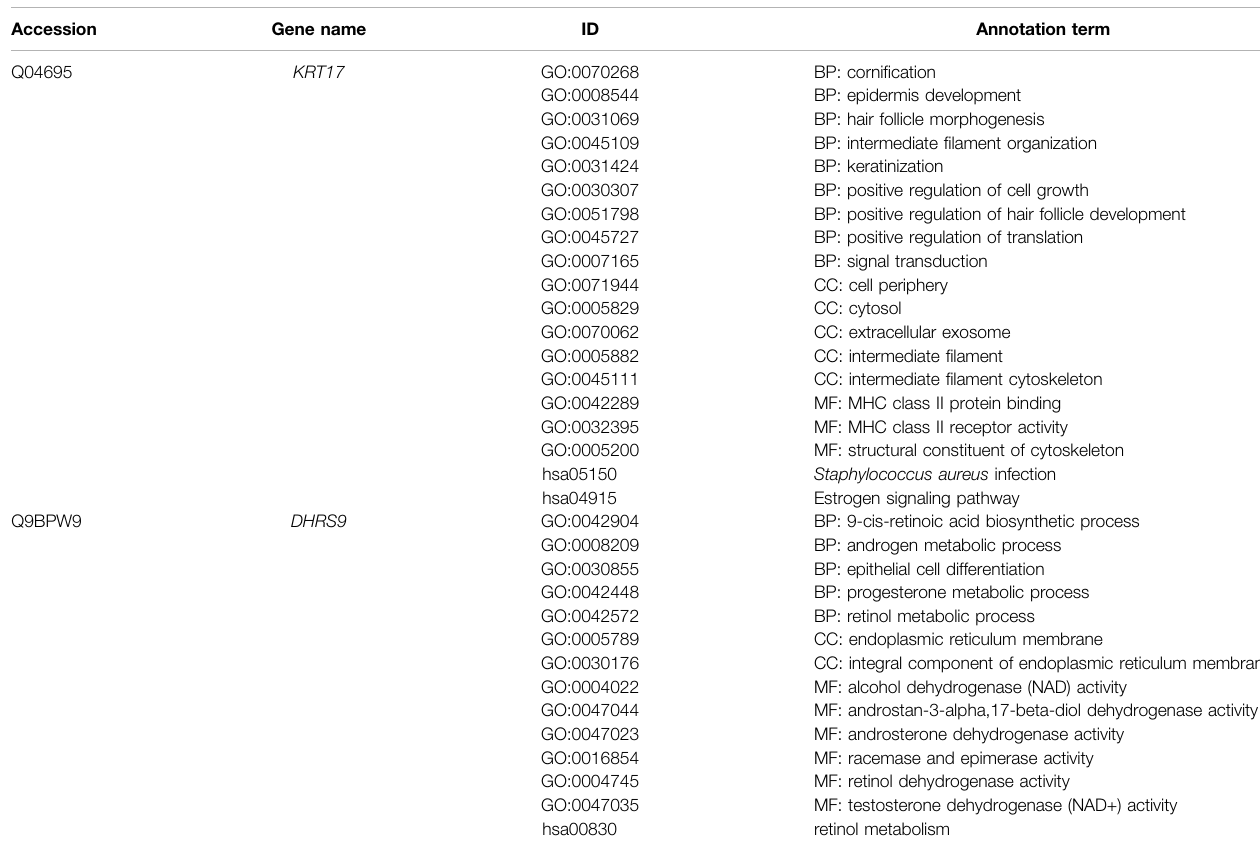
TABLE 5 | Annotation of KRT17 and DHRS9.